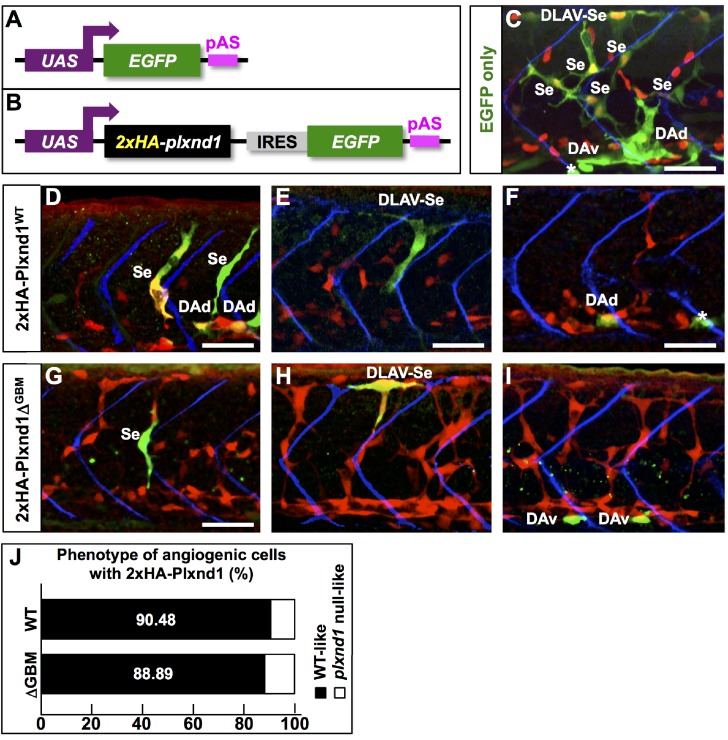
A Plxnd1 form deficient in GIPC binding because of deletion of the receptor’s GBM (Plxnd1ΔGBM) is active in vivo.(A, B) Diagrams of the GAL4-responsive constructs used for forced endothelial expression in plxnd1fov01b; Tg(fli1a:GAL4FF)ubs4; Tg(flt1:nls-mCherry)skt7 embryos. (A) Construct for expression of the green fluorescent marker EGFP (negative control). (B) Construct for bicistronic coexpression of 2xHA-Plxnd1 (2xHA-Plxnd1WT or 2xHA-Plxnd1ΔGBM) and EGFP (to fluorescently label cells with exogenous 2xHA-Plxnd1 expression). (C–I) Confocal lateral images of 32 hpf embryo trunks. Anterior, left; dorsal, up. Scale bars (white horizontal lines), 50 μm. Image colors: Cells with exogenous gene expression, green (EGFP+); arterial nuclei, red; somite boundaries, blue. The position of EGFP+ clones within the arterial tree indicated as follows. DLAV (Dorsal Longitudinal Anastomotic Vessel), Se (Segmental vessel), DLAV-Se (both Se and DLAV), DAd (dorsal side of the Dorsal Aorta), and DAv (ventral side of the Dorsal Aorta). White asterisks mark clones with non-endothelial, ectopic expression. (C) Expression of EGFP alone fails to rescue the vascular defects of plxnD1fov01b mutants. EGFP+ arterial cells form mispatterned, ectopic and over branched Se vessels and aberrantly shaped DLAVs. (D–I) EGFP+ cells expressing 2xHA-Plxnd1WT (D–F) or 2xHA-Plxnd1ΔGBM (G–I) rescue the vascular defects of plxnd1fov01b mutants. These cells displayed a WT-like phenotype. Briefly, they were not found within ectopic Se sprouts, displayed normal shapes according to their position within Se and DLAVs and, when found at the base of a sprout, were properly positioned just anterior to a somite boundary; see (Zygmunt et al., 2011). (J) Bar graph. Quantification of the vascular phenotype (WT-like or plxnd1 null-like) of EGFP+ angiogenic endothelial cells (those at the DLAV, DLAV-Se, and DAd positions but not the DAV position) with exogenous expression of 2xHA-Plxnd1WT (top) or 2xHA-Plxnd1ΔGBM (bottom) in plxnd1fov01b mutants. Both 2xHA-Plxnd1 forms rescue the vascular defects of plxnd1fov01b mutants with similar efficiency. Quantifications. We scored the vascular phenotype of angiogenic endothelial cells in plxnd1fov01b mutants coexpressing EGFP and the following 2xHA-Plxnd1 forms: 2xHA-Plxnd1WT (21 clones, 15 embryos), 2xHA-Plxnd1ΔGBM (nine clones, 17 embryos). Note that embryos harboring only DAV clones were excluded from this analysis. The significance value (p=1) was calculated using a two-sided Fisher’s Exact test. The significant difference value is p<0.05. The proportions were not significantly different. For additional supplementary information related to this figure, see Supplementary file 1, Supplementary file 3 and Supplementary file 8. This figure is related to Figure 2.